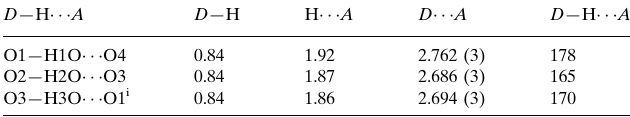
Hydrogen-bond geometry (A˚ , (cid:2)